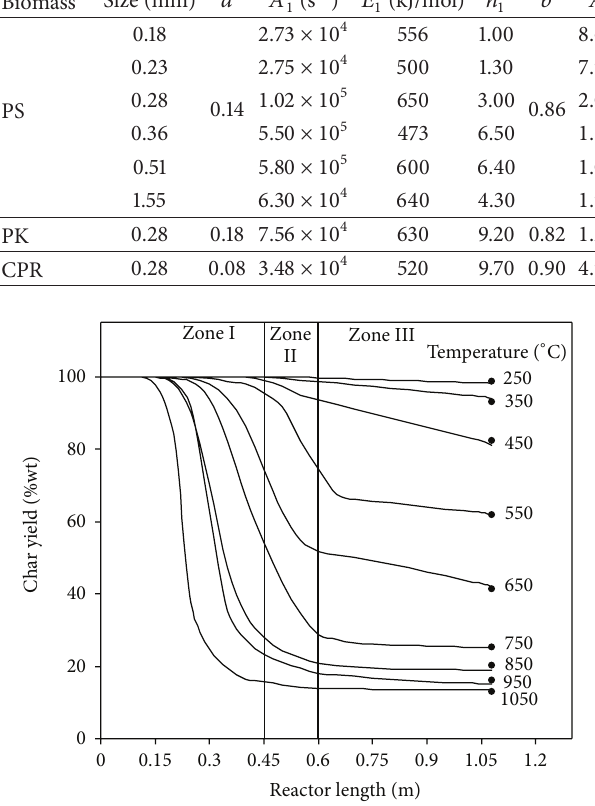
Figure 8: Char yields calculated from the pyrolysis model for palm shell at the average particle size of 0.28 mm and N 2 flow rate 200 cm 3 /min (line is by simulation and dot represents experimental data).